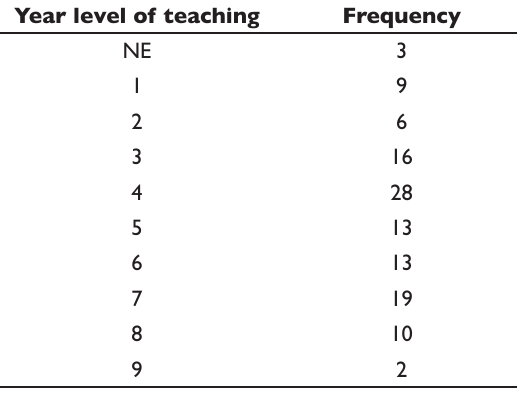
Table 2: Participating teachers’ teaching